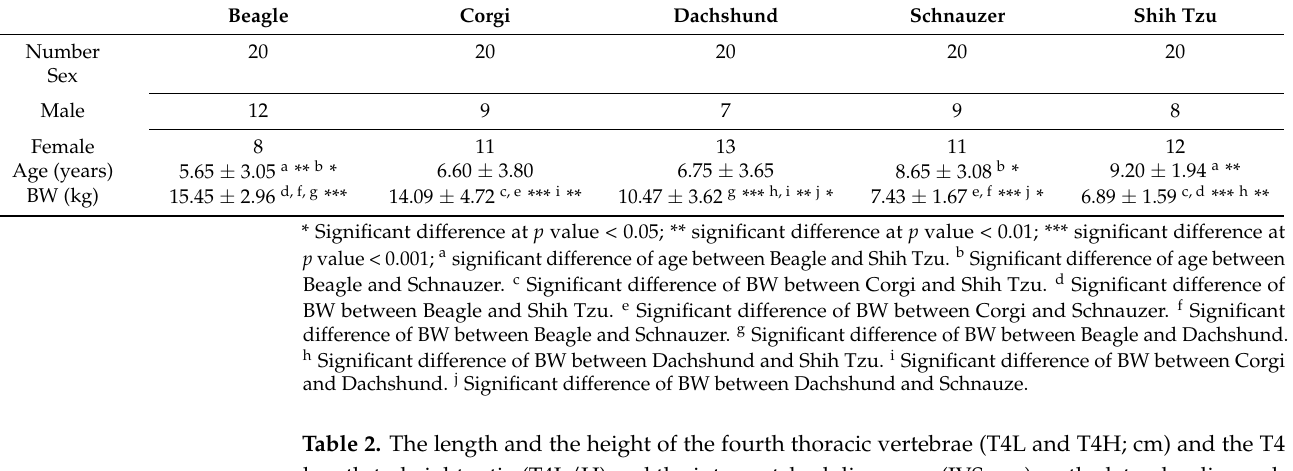
Table 1. Clinical demographic information, including sex, age, and body weight (BW) of all dog breeds. Data were expressed as mean ± SD. Beagle Corgi Dachshund Schnauzer Shih Tzu